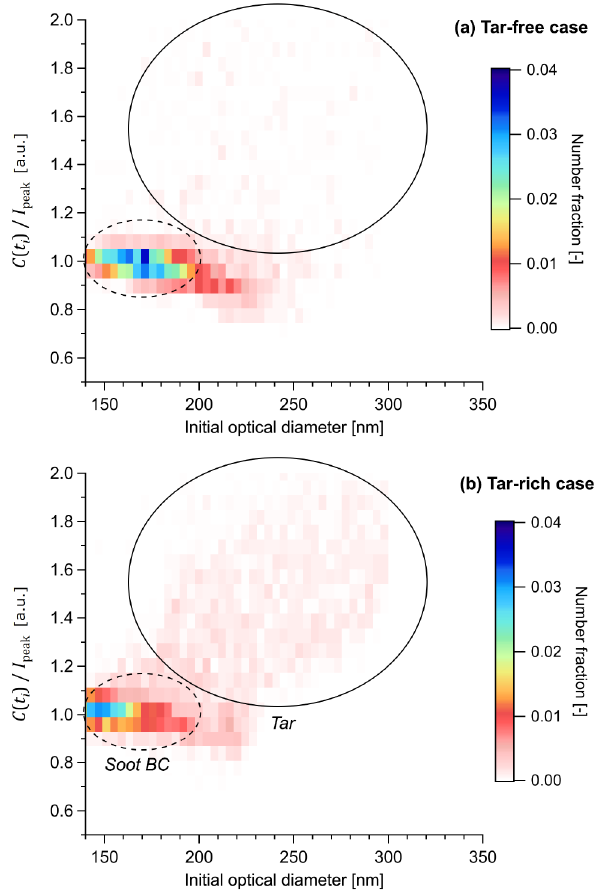
Figure 4. Incandescing tar particles distinguished from soot BC by their scattering properties in the SP2. The abscissa shows the opti- cal particle diameter prior to evaporation, calculated from C(t i ) with m = 1 . 9 + 0 . 8 i . The ordinate shows the ratio of optical-equivalent and incandescent-equivalent particle diameters, C(t i )/I peak , calcu- lated with the optical properties of soot BC. The colour scale shows the number fraction of particles in each bin (that is, a normalized joint probability histogram). Note that C(t i )/I peak employs the op- tical diameter at time of incandescence t i and therefore represents the optical diameter of the refractory component of the particle. Therefore, for soot BC, C(t i )/I peak ≈ 1 by definition, although de- viations below unity are observed for larger particles where light- scattering transitions from the Rayleigh regime to the geometric regime (Moteki and Kondo, 2010). Thickly coated soot BC particles are also expected to fall on the C(t i )/I peak ≈ 1 line, since volatile coatings evaporate before C(t i ) is measured, as discussed further in the text. In contrast, C(t i )/I peak is very different from unity in the presence of particles which contain non-incandescing but refractory